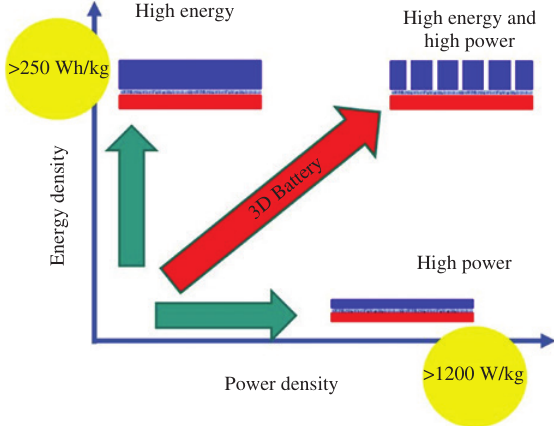
Figure 15: Schematic view of energy density as a function of power density for 2D, 3D, and thick-film electrodes (red: current collector of the electrode; blue: active material of the electrode). The yellow marked values of energy density and power density are related to target values on cell level for the year 2025 based on